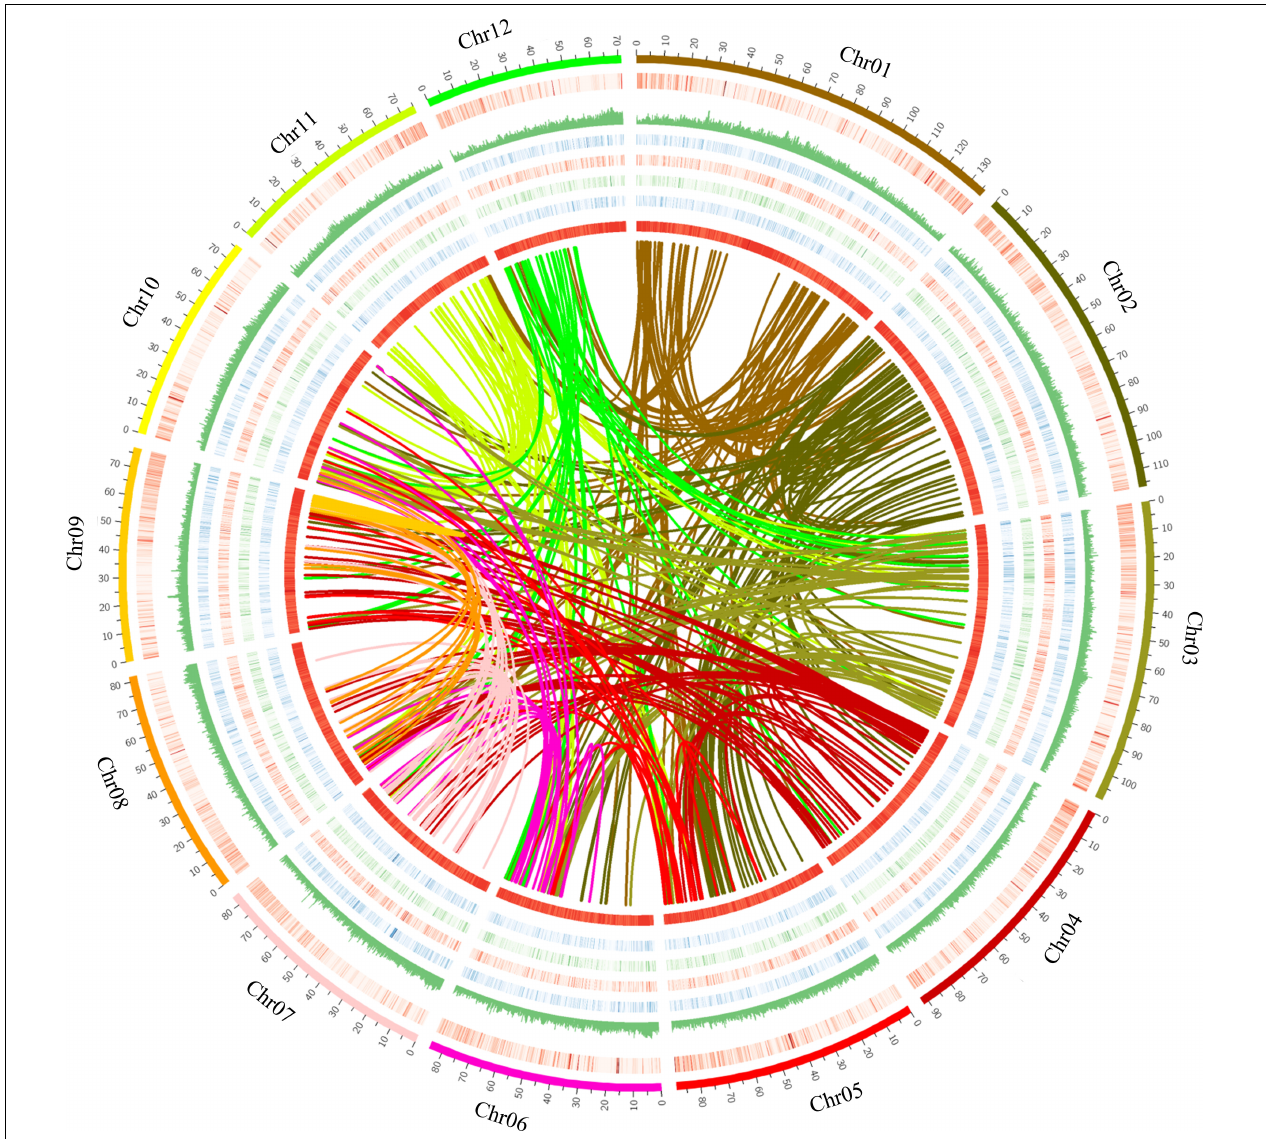
FIGURE 1 | The genomic landscape of Sindora glabra tree. The features from outside to inside are chromosomes, gene density (0–1), repeat coverage (0–1), expression levels (0–15) from adult stems, leaf, root, and young stems, GC content (0–0.5), and genome synteny. Twelve chromosomes were ordered by megabases size and featured in 200 kb intervals across the chromosomes. Arcs with different colors indicated syntenic blocks. Circos was used to construct the